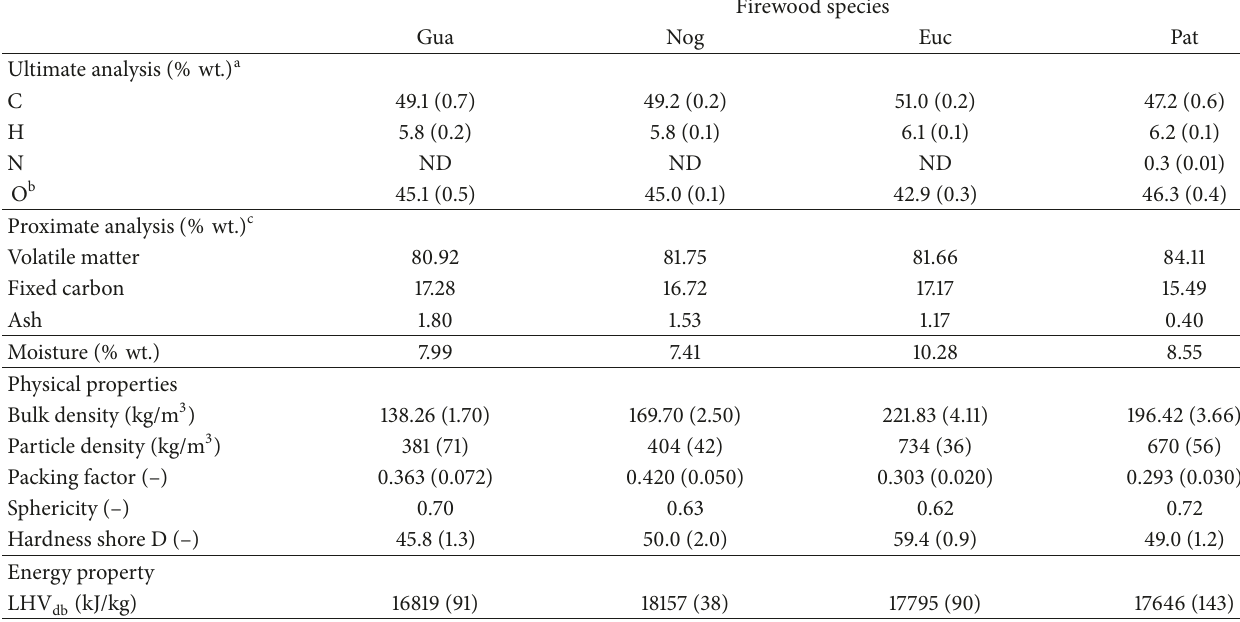
Table 4: Physicochemical properties of firewood species ( ± standard deviation).